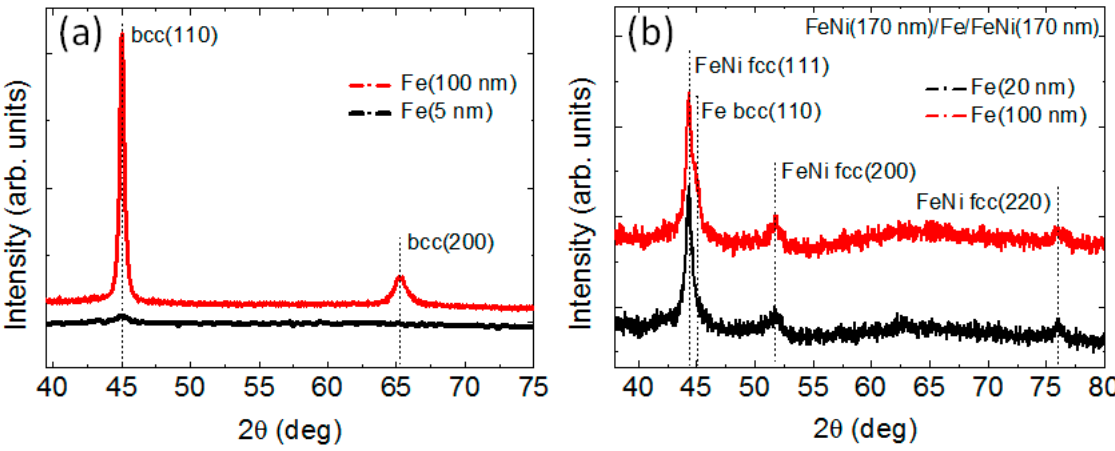
Figure 3. X-ray diffraction pattern for Fe films ( a ) and FeNi(170 nm)/Fe(l Fe )/FeNi(170 nm) trilayers ( b ).